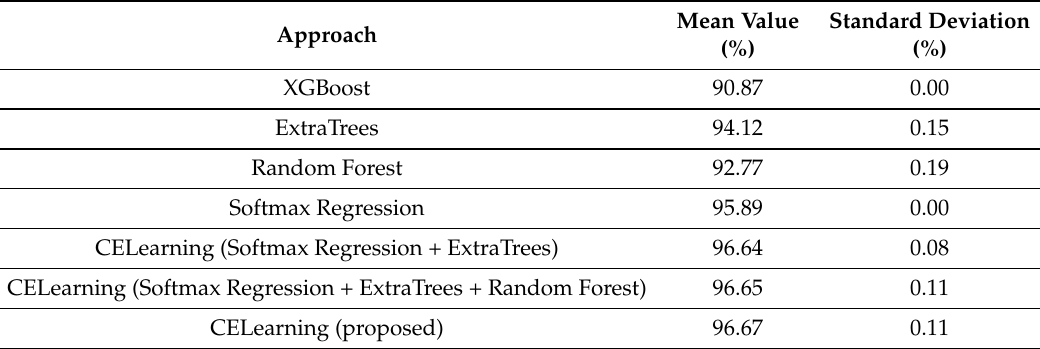
Table 5. Comparison of different combinations of four classifiers based on handcrafted feature extraction.